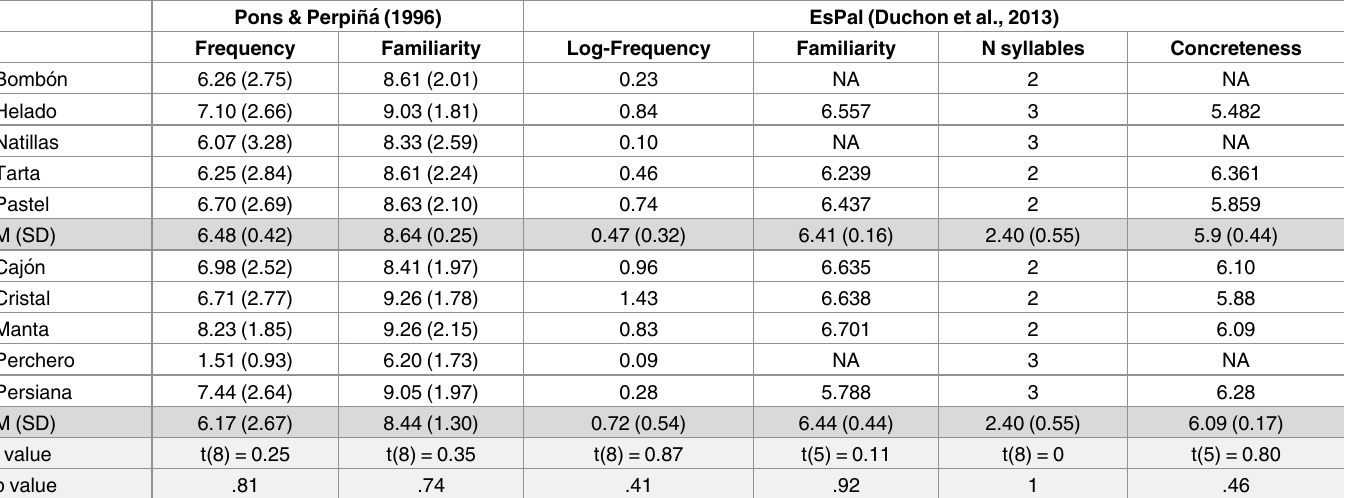
Table 1. Psycholinguistic characteristics of the words used as deviant auditory stimuli in the cross-modal oddball task. Pons & Perpi ñ a´ (1996)